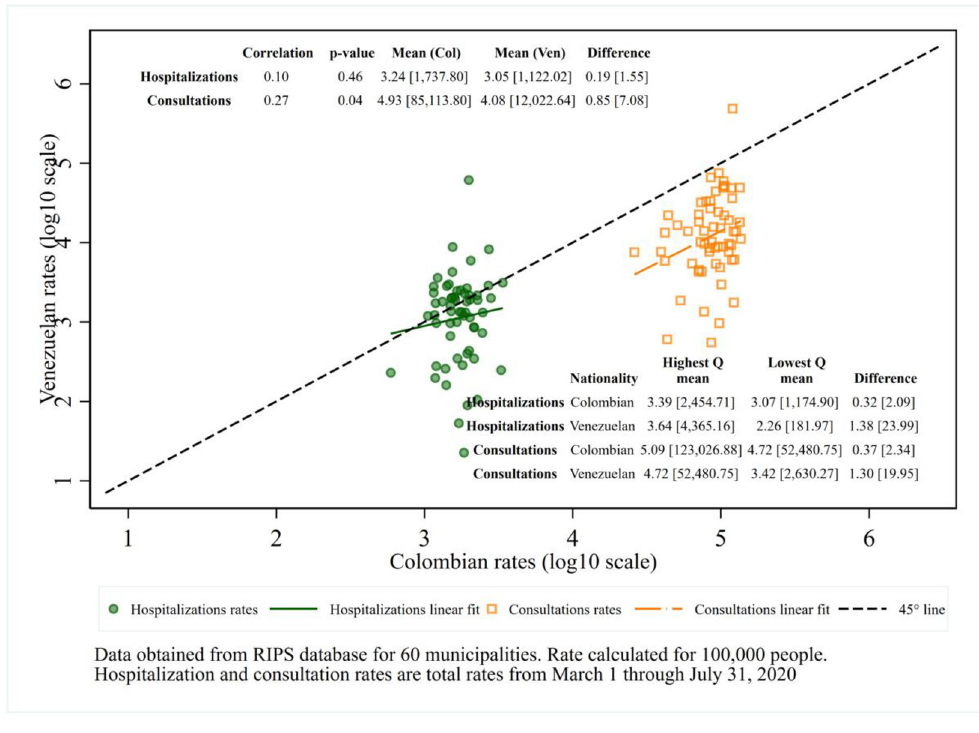
Fig 5. Hospitalization and consultation rates in 2020: Colombians versus Venezuelans.